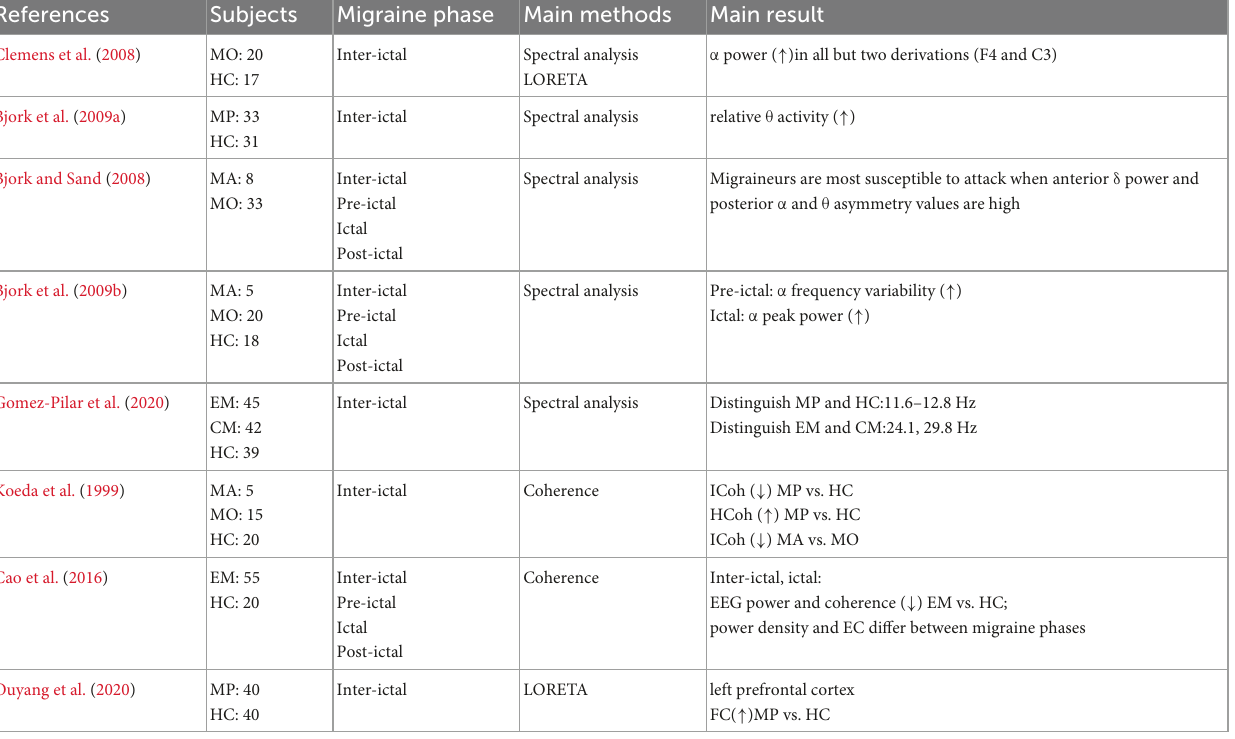
TABLE 1 Summary of Resting-state EEG studies in